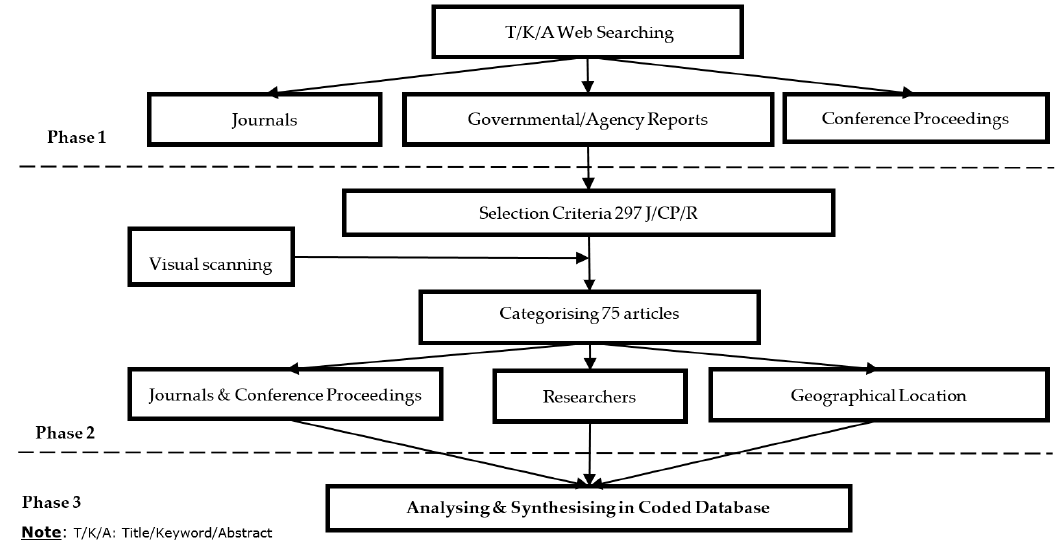
Figure 1. Research Methodology.